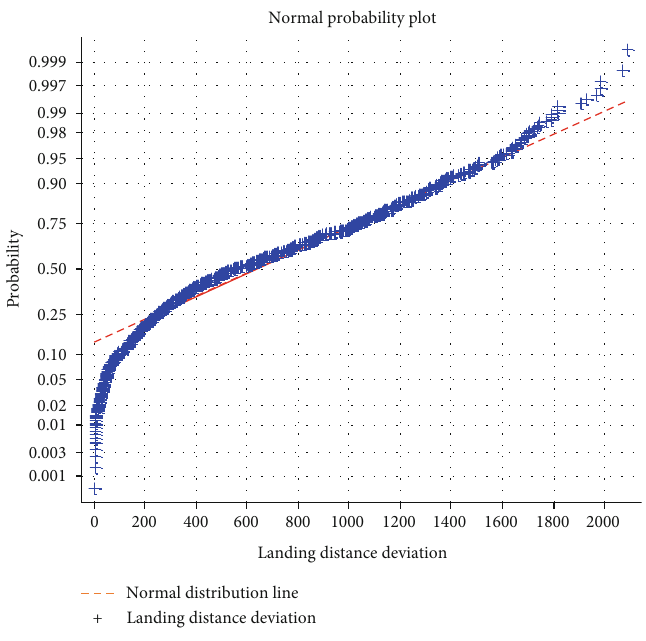
Figure 13: Falling-point deviation normality